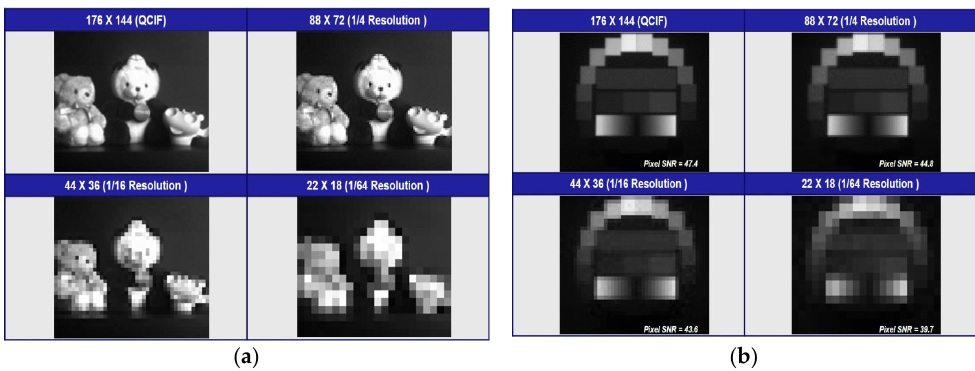
Figure 10. ( a ) Measured images for multi-mode pixel and ( b ) measured images for standard chart to obtain SNR. Table 1. Performance summary of the proposed CIS.